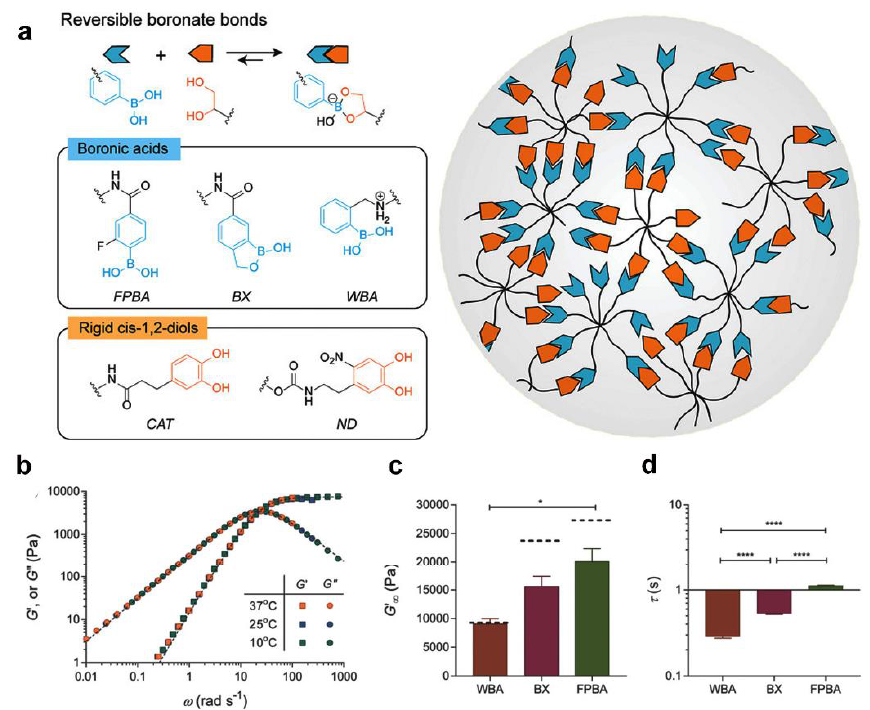
Figure 12. Design of covalent adaptable networks based on dynamic boronate bonds for cell culture. ( a ) Schematic of covalent, adaptable networks based on boronic-ester-crosslinked hydrogels ( b ) Frequency-sweep spectrum of boronate hydrogels. ( c ) Comparisons of the high-frequency plateau moduli (* significance level of p < 0.05) and ( d ) the network relaxation times of different hydrogel (**** significance level of p < 0.0001). (Reprinted/adapted with permission from Ref. [87], 2018, Tang et al.).